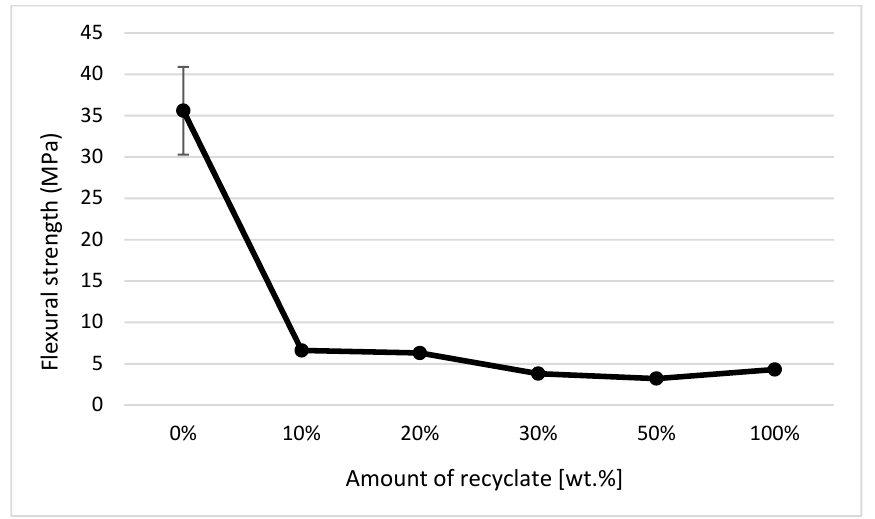
Figure 20. Dependence of the flexural strength on the amount of the recycled material after exposure of samples to elevated temperature.